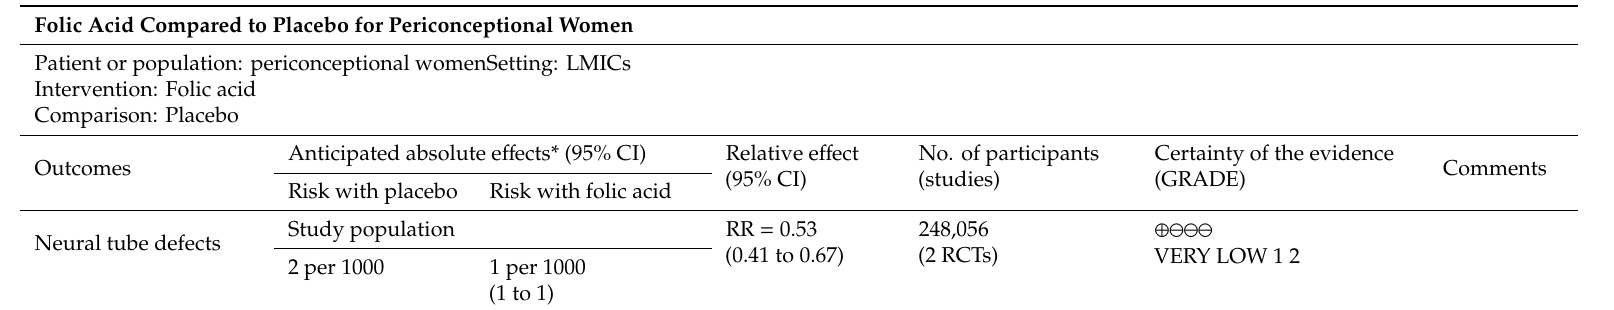
Table 4. Periconceptional folic acid supplementation compared to